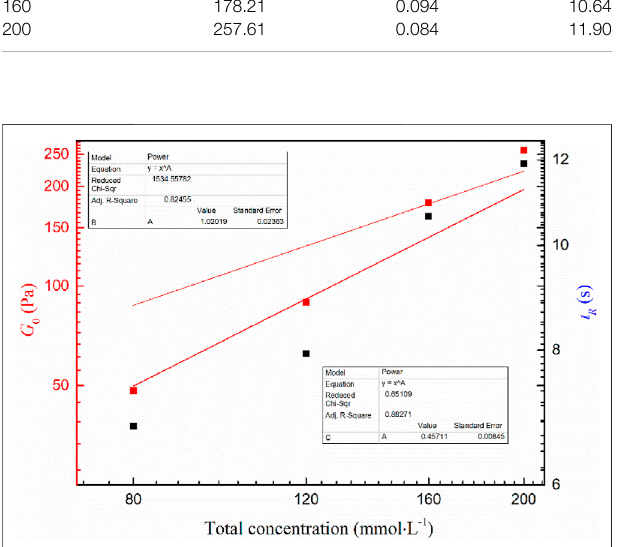
FIGURE 6 | G 0 and τ R versus total concentration of the MSA/CTAB